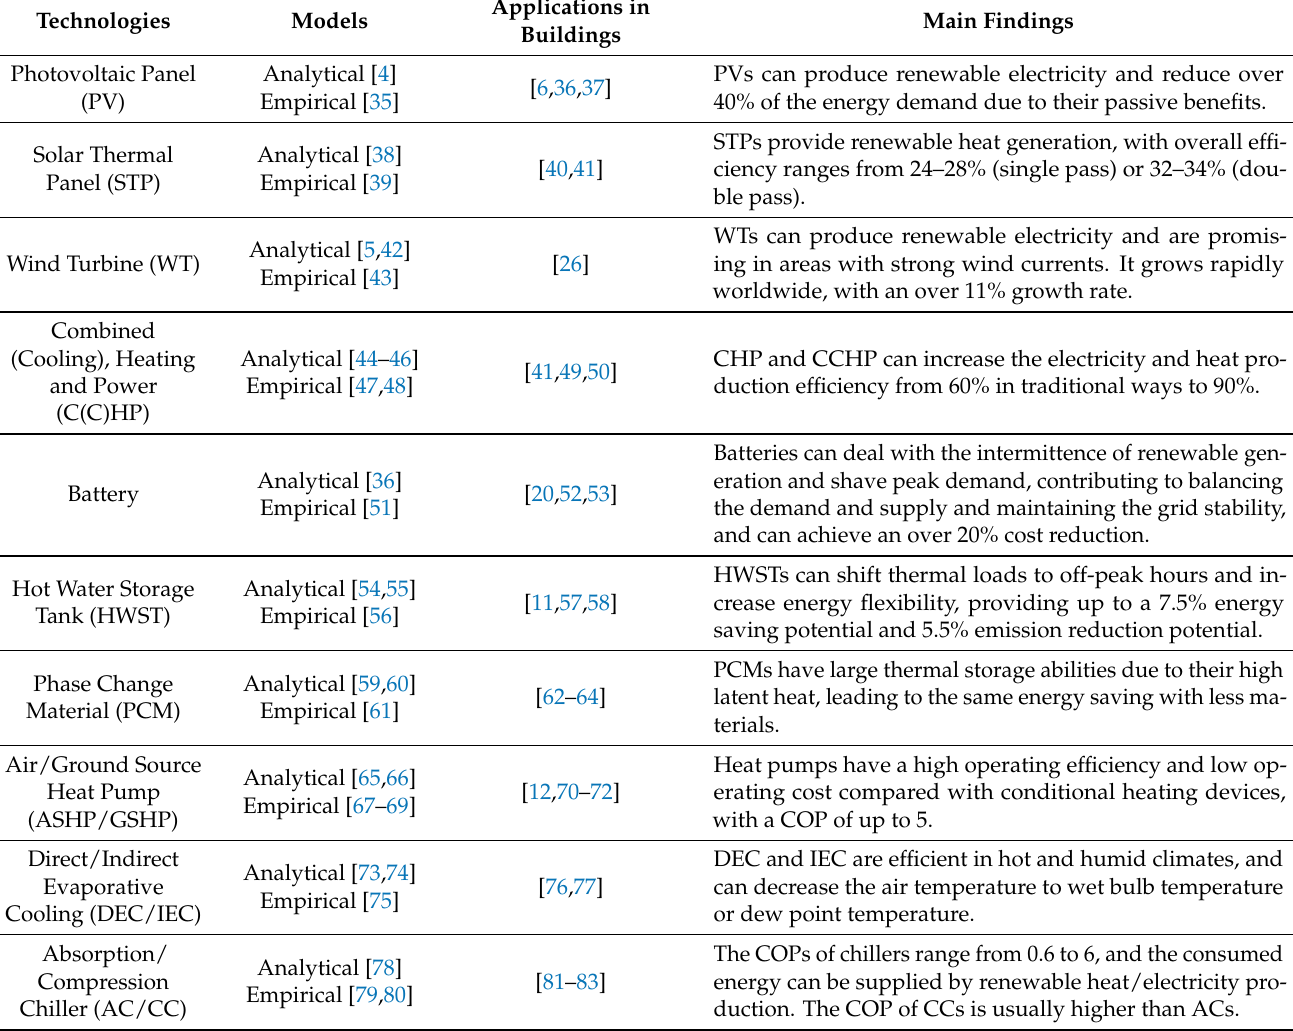
Table 1. Studied technologies in